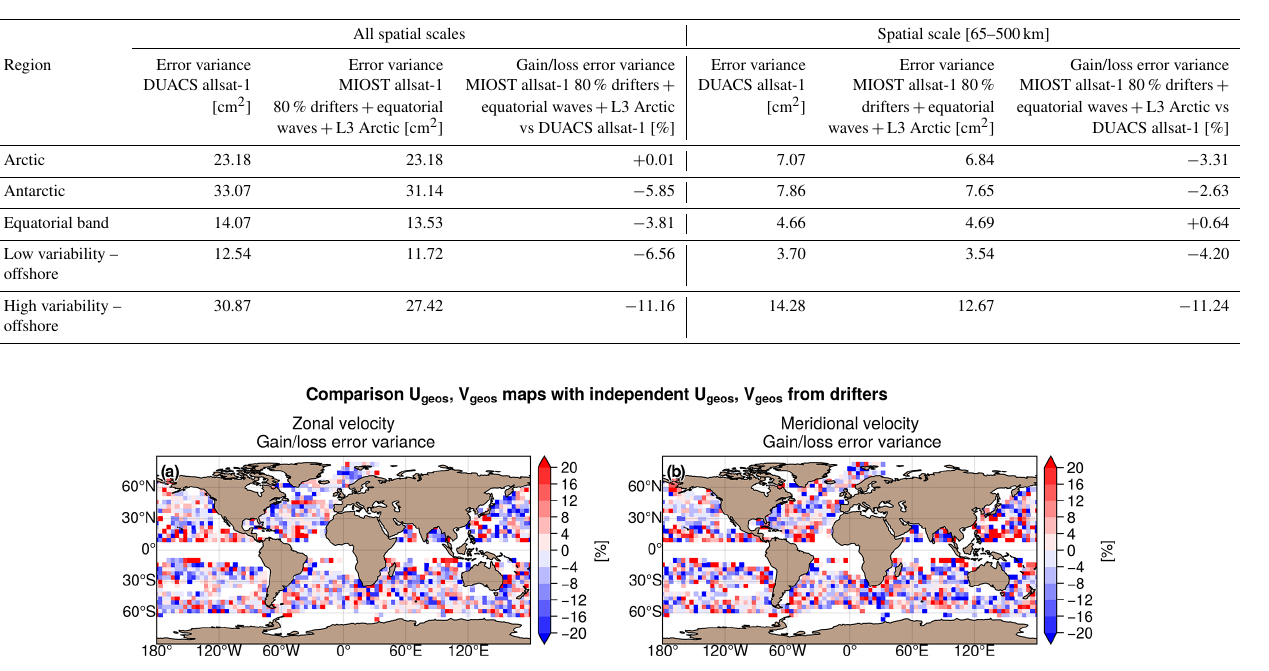
Figure 12. Gain/loss of the mapping error variance of SLA in the MIOST allsat-1 80% drifters + equatorial waves + L3 Arctic experiment relative to the DUACS allsat-1 mapping error variance for (a) all spatial scales and (b) the scale between 65 and 500km. Blue colour means a reduction of error variance in MIOST. Table 8. Regionally averaged mapping error variance and gain/reduction of error variance on the SSH variable between MIOST allsat-1 80% drifters + equatorial waves + L3 Arctic and DUACS allsat-1.